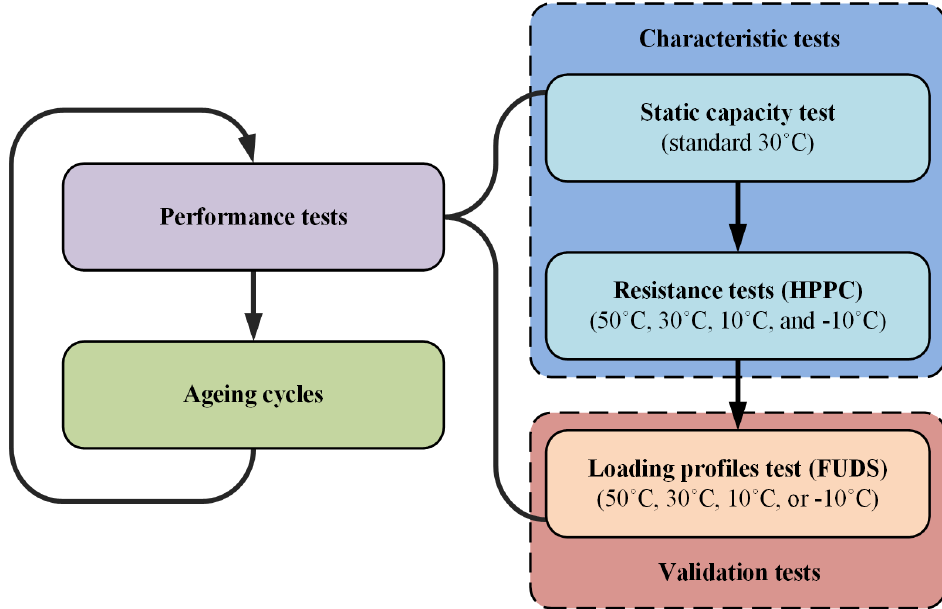
Figure 3. The procedure of